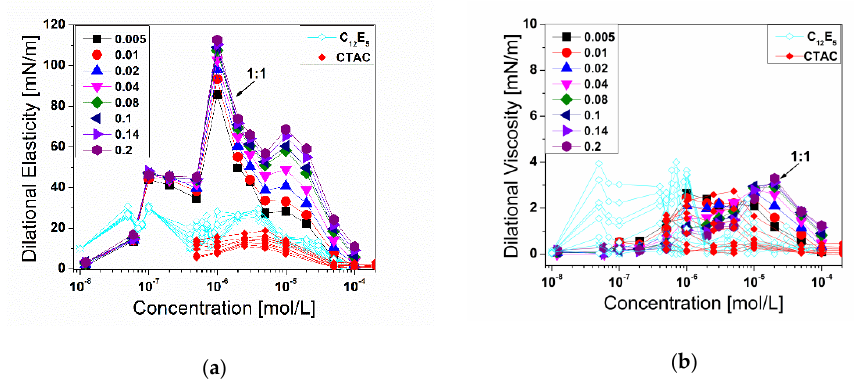
Figure 3. Surface dilatational moduli of aqueous solutions of mixture C 12 E 5 / CTAC 1:1 (in the presence of 0.1 M NaCl and at temperature t = 20 °C) as a function of the total surfactant concentration and the frequency of oscillations. ( a ) The dilatational elasticity of the mixed system is given as solid symbols. The open symbols represent single surfactants systems reported before in references [16,17]. ( b ) Surface dilatational viscosity of the mixed system.